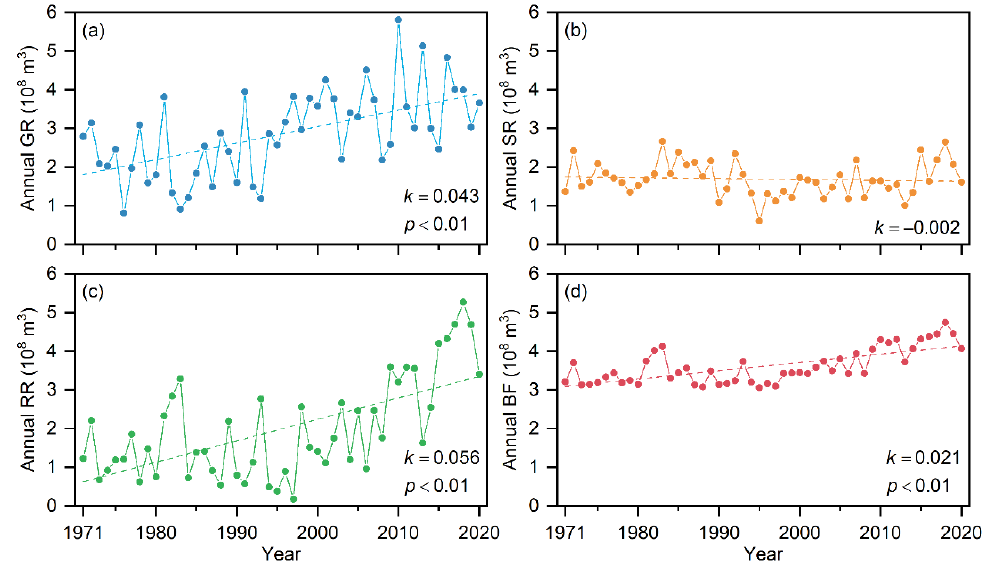
Figure 10. Interannual variation of simulated runoff components. ( a ) Glacier runoff (GR); ( b ) Snow runoff; ( c ) Rainfall runoff; ( d ) Baseflow.